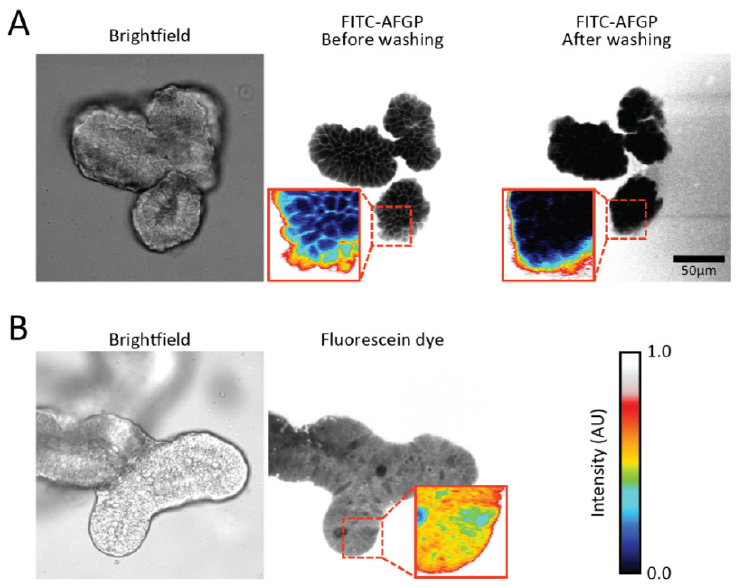
Figure 3. Fluorescence images of organoids in the presence of FITC-labeled AFGP. ( a ) Brightfield and fluorescence images of an organoid with FITC-AFGP in the medium reveal that fluorescence is observed on the cell outlines. Washing of the imaging wells with buffer eliminated the fluorescence pattern; ( b ) Brightfield and fluorescence images of an organoid with fluorescein diacetate in the medium show that fluorescence is present in the cytoplasm of most cells. Pixel intensities are colored in insets to highlight the observed fluorescence patterns. Colors represent the same intensities in all images.